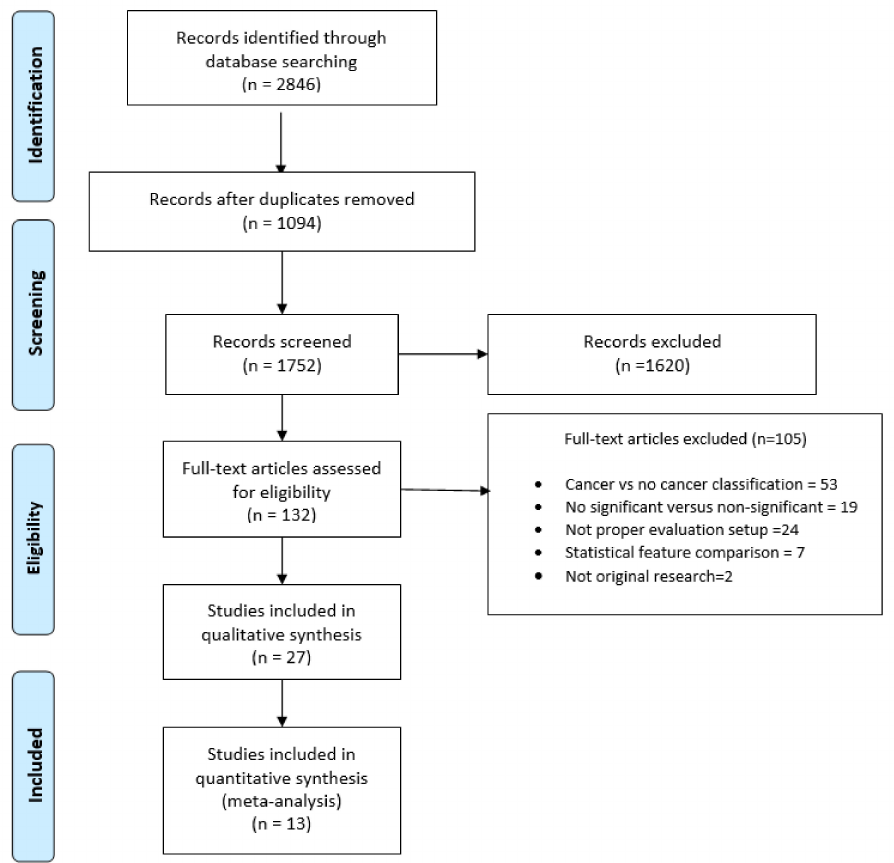
Figure 1. Systematic review flow diagram, modified from [32].